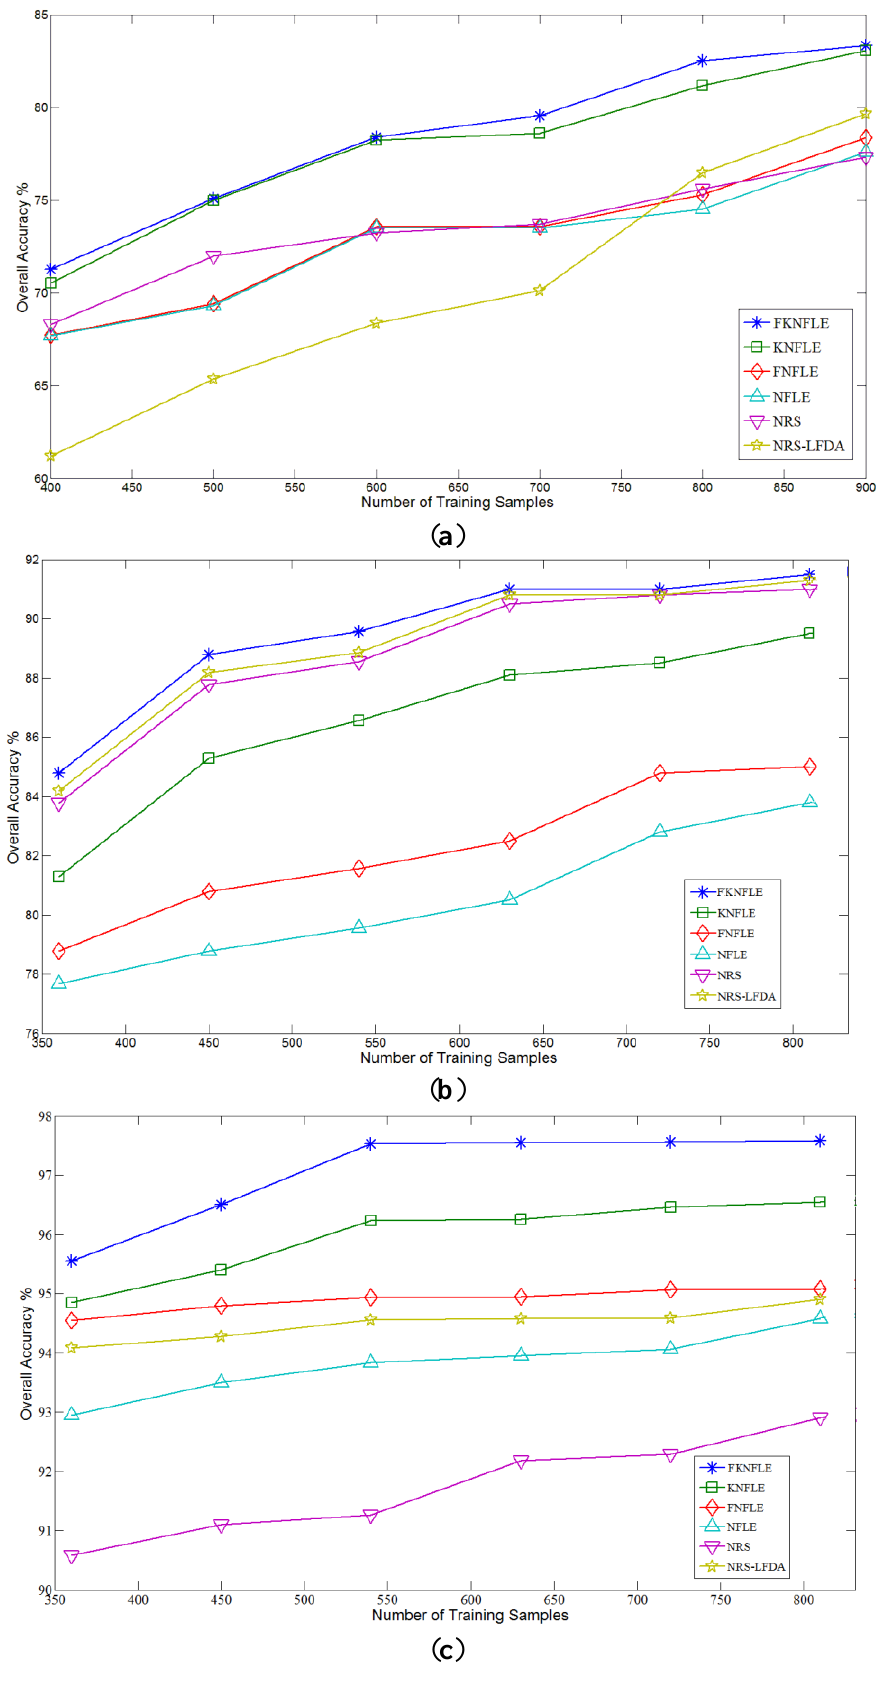
Figure 5. The accuracy rates versus the number of training samples for datasets ( a ) IPS-10; ( b ) Pavia University; and ( c ) Pavia City